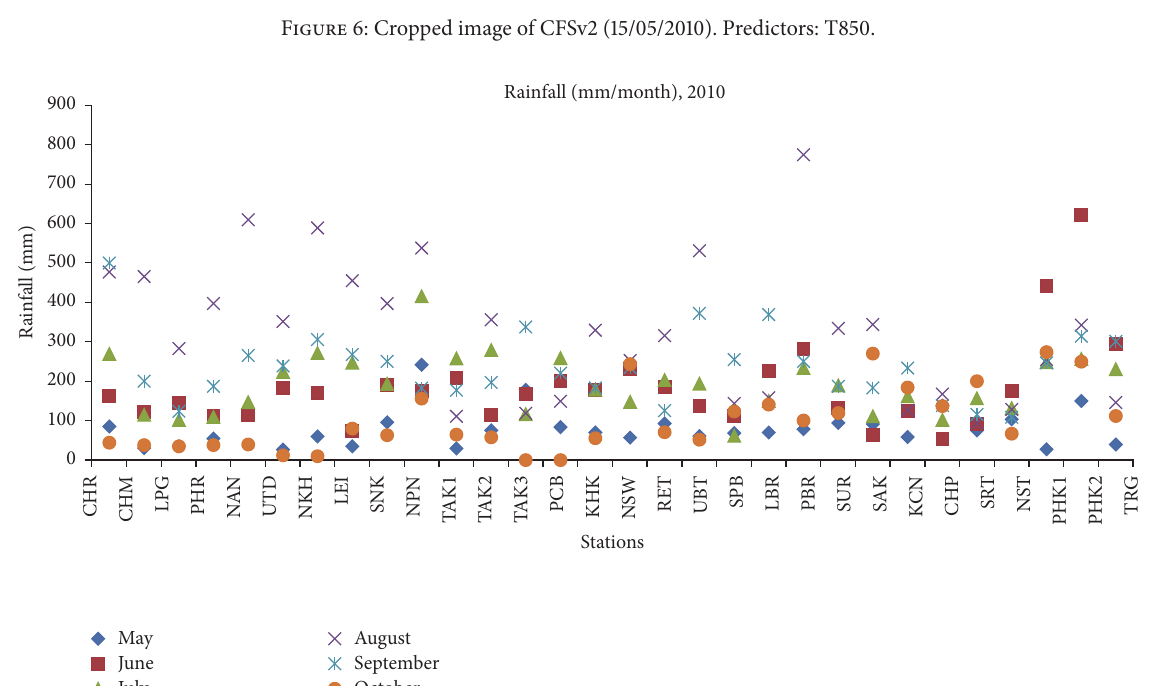
Figure 7: Rainfall (mm/month) at the 30